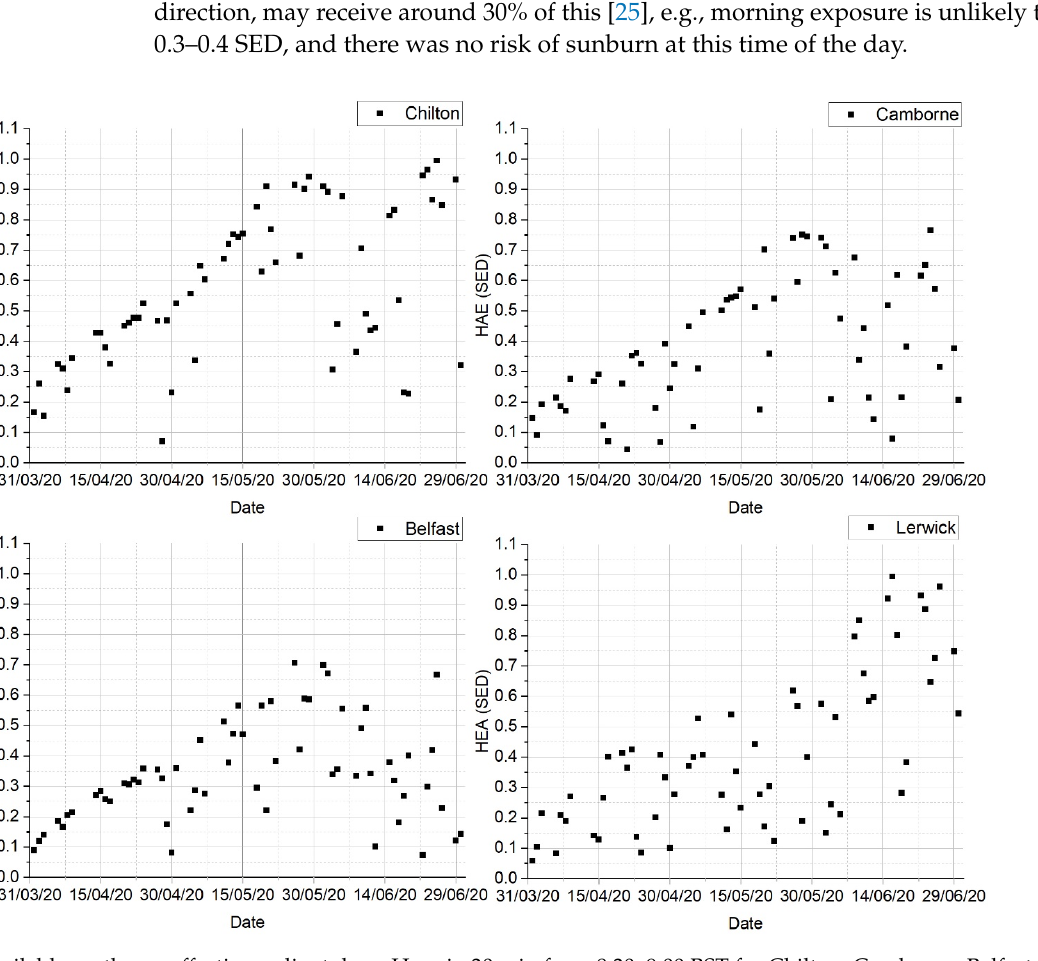
Figure 1. Available erythema effective radiant dose, H AE , in 30 min from 8:30–9:00 BST for Chilton, Camborne, Belfast, and Lerwick in April–June 2020.